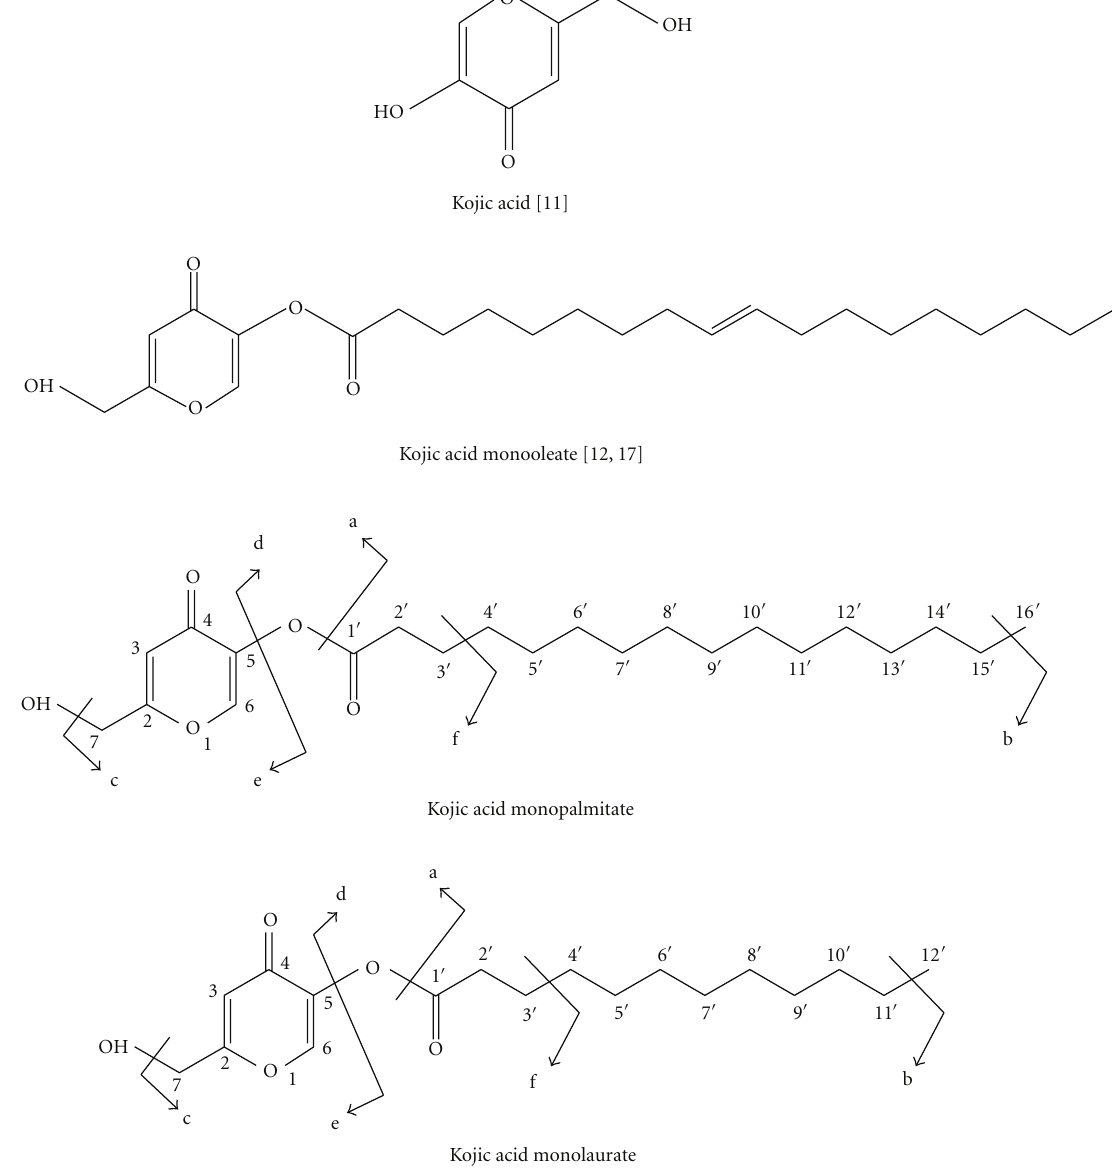
Figure 1: Chemical structure of kojic acid (KA), kojic acid monoeolate (KAMO), kojic acid monopalmitate (KAMP) and kojic acid mono- laurate